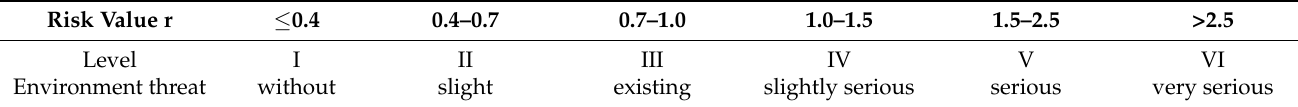
Table 1. Risk value classification of manure pollution load from livestock and poultry. Risk Value r ≤